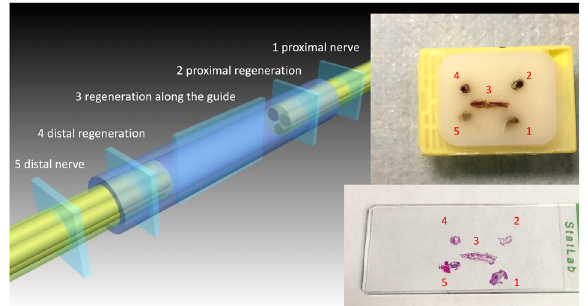
Fig. 5 Sampling procedure de fi ned fi ve regions of interest: 1-the transverse section of the proximal stump about 1 mm proximal to the lesion; 2-the transverse section of the regenerated tissue about 1 mm distal to the proximal stump; 3-the longitudinal section of the arti fi cial nerve-guide; 4-the transverse section of the regenerated tissue about 1 mm proximal to the distal stump; 5-the transverse section of the distal stump about 1 mm distal to the lesion. Sampled regions were embedded into paraf fi n (upper inset) and positioned according to a fi xed scheme that helps in standardizing the histological reading (lower